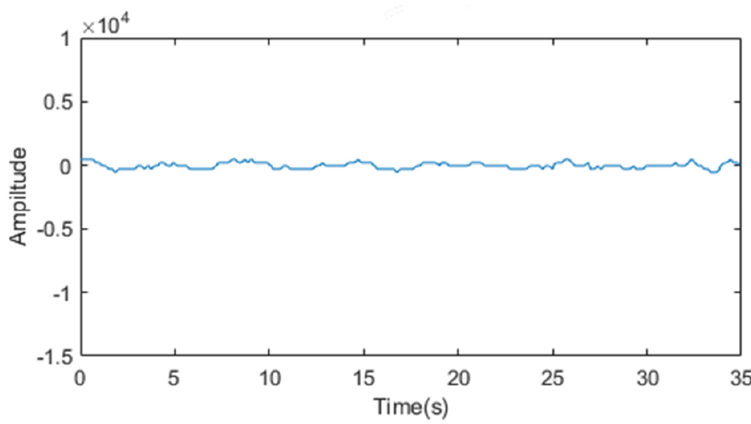
Figure 2. Signal without testers.